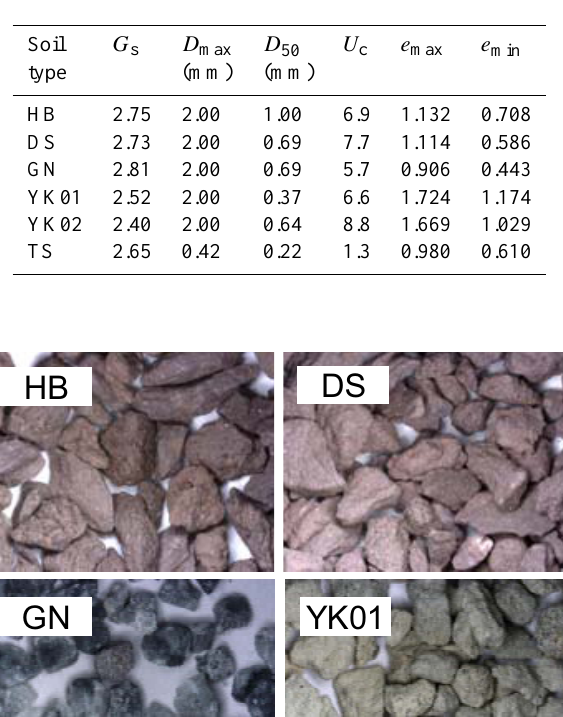
Table 1. Physical properties of the test materials.